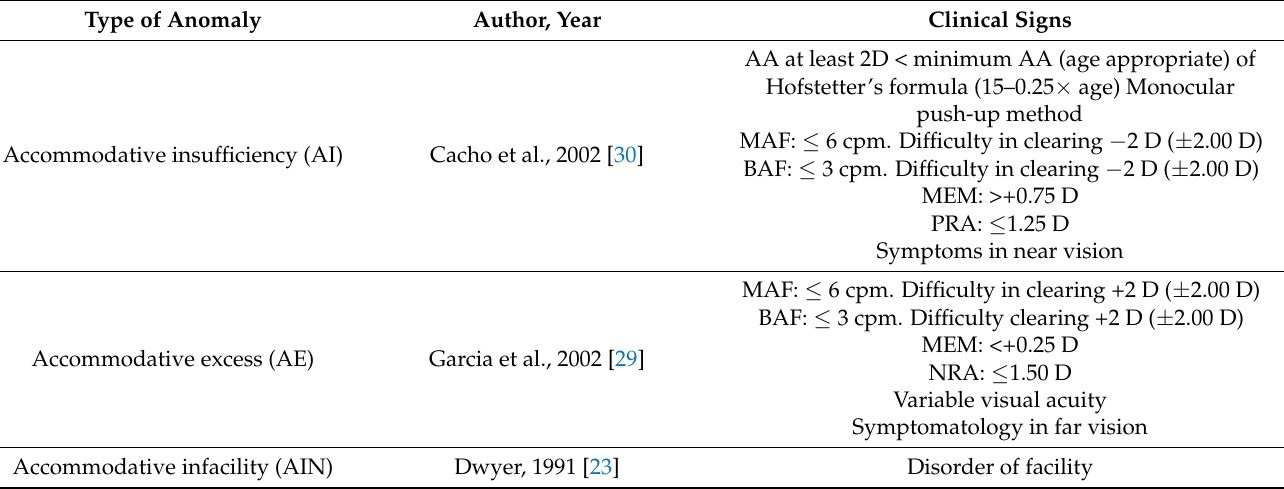
Table 2. Diagnostic criteria defined in the peer-reviewed literature for accommodative anomalies that have been used in the current